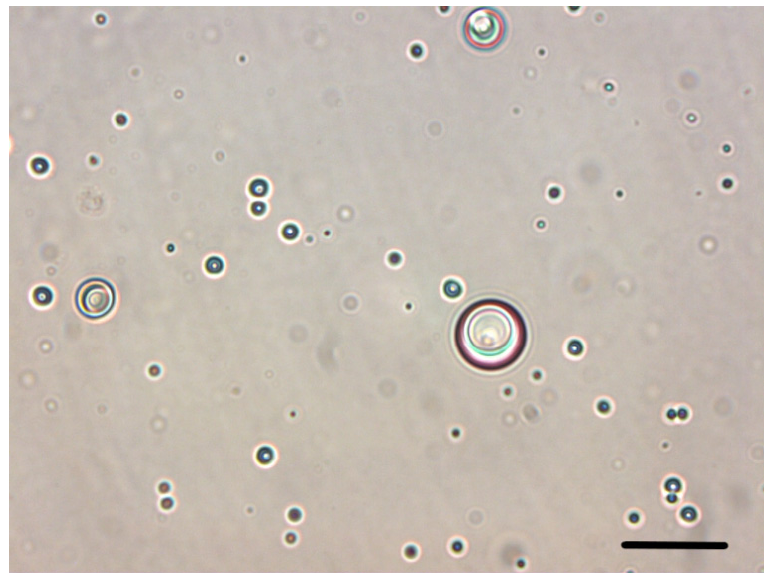
Figure 3. Light micrograph of a freshly prepared Janus emulsion with chitosan-stabilized AuNPs and MNPs (scale bar: 20 µm).